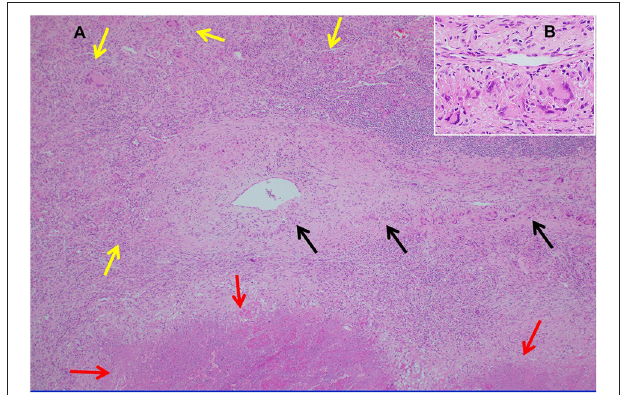
FIGURE 9 | (A) Lung biopsy, necrotizing sarcoid granulomatosis. Low power image (H&E stain, 40x) of nodular replacement of a region of lung parenchyma by numerous non-necrotizing granulomas with admixed mild chronic inflammation, which is different in its appearance from classic nodular sarcoidosis by the presence of a broad area of parenchymal necrosis (red arrows) and prominent vascular involvement by non-necrotizing granulomas and chronic inflammation (black arrows). (B) Inserted higher power image of the pulmonary vessel from (A) with marked mural multinucleated giant cell rich inflammation distorting and compressing the vessel wall without associated vascular